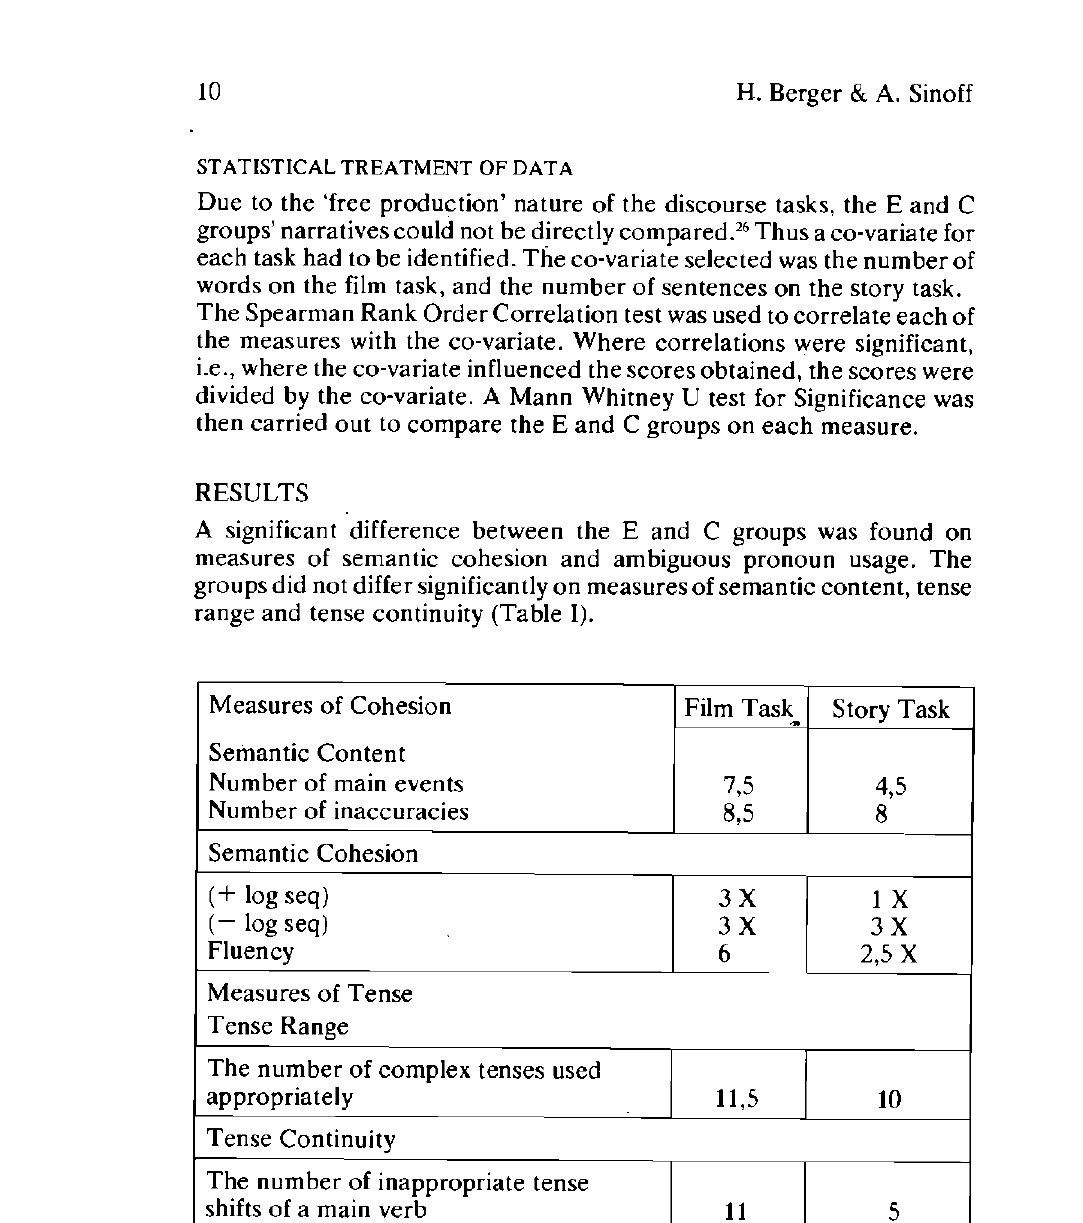
TABLE 1. Summary table of significant differences between the Ε and C groups on measures of cohesion, tense and